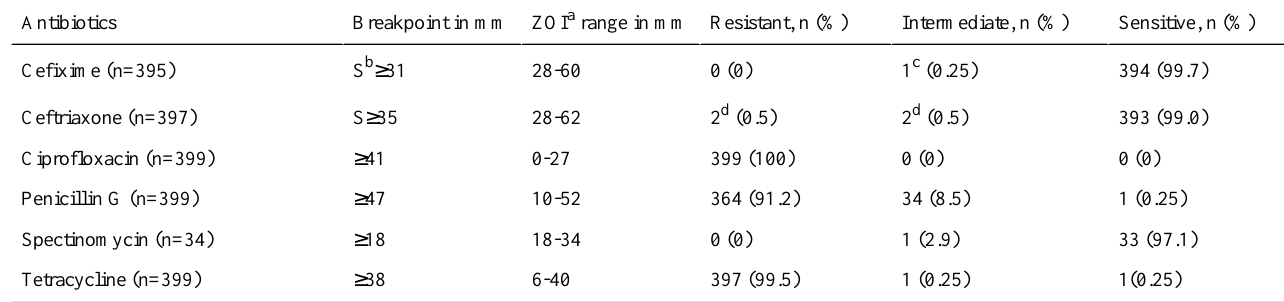
Table 2. Disk diffusion resistance characteristics.